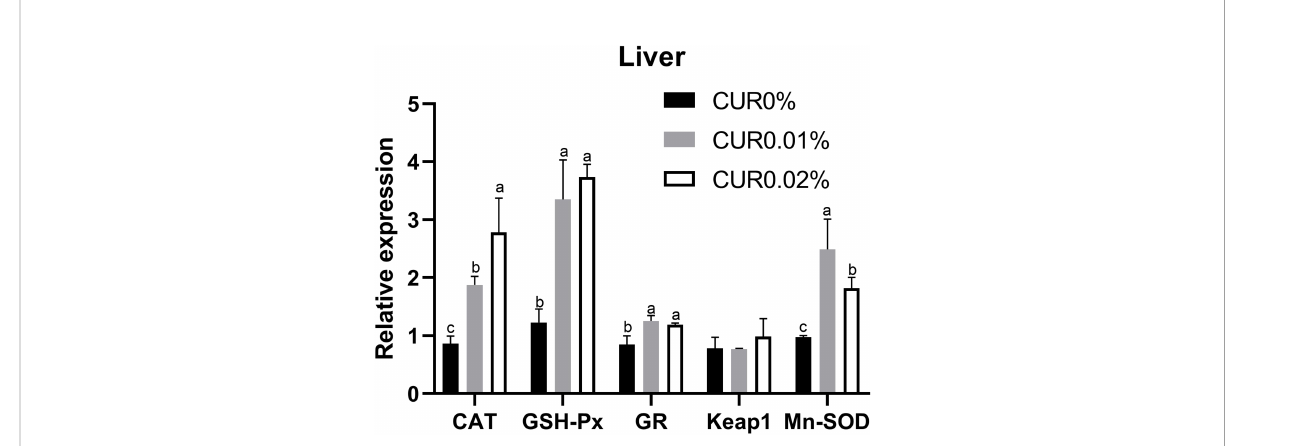
FIGURE 2 The relative expression of antioxidant genes in liver of the greater amberick after the 8-week feeding experiment in Experiment I. Different letters above bars indicate signi fi cant differences at the 0.05 level. Data are expressed as the means ± SD